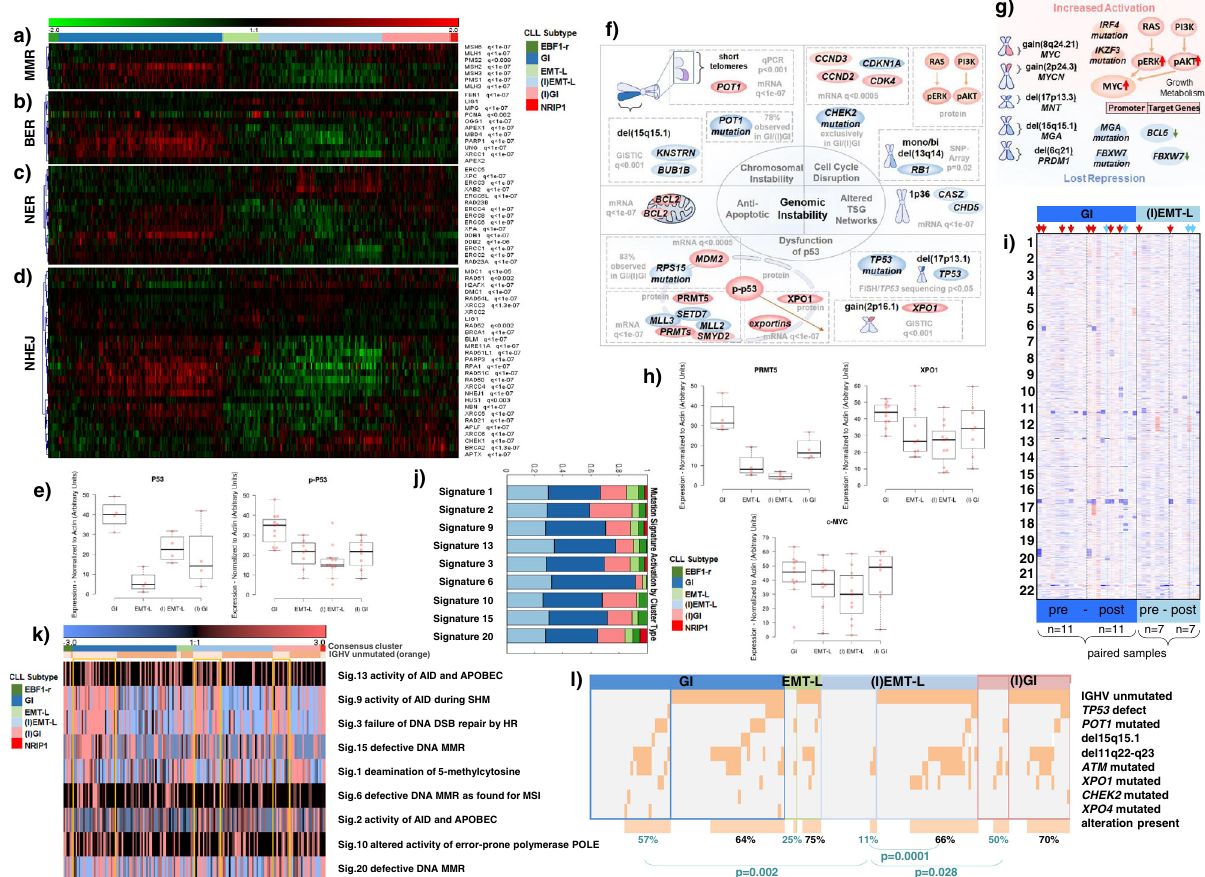
Fig. 3 Biological processes operative in genomically instable CLL. a – d Heatmap showing expression pro fi les ( n = 337) for genes involved in a mismatch repair (MMR), b base excision repair (BER), c nucleotide excision repair (NER), d non-homologous end joining (NHEJ). FDRs of DEGs (GI vs. (I)EMT-L) are indicated (q). Single genes may be involved in multiple processes. e Protein expression in CLL subtypes; p53 ( n = 4 each), phospho-p53 (GI/(I)EMT-L: n = 11 each, (I)GI/EMT-L: n = 8 each) (normalized to actin). f , g Models summarizing alterations which contribute to f genomic instability, g activation of MYC family members in GI/(I)GI. Source/method (e.g., mRNA/GISTIC) and signi fi cance/frequencies are shown in gray, along with estimated mode of regulation/biological effect (red: increase/activation; blue: decrease/inactivation). h Protein expression in CLL subtypes; PRMT5 ( n = 4 each), XPO1/ cMYC (GI/(I)EMT-L: n = 11 each, (I)GI/EMT-L: n = 8 each) (normalized to actin). i Heatmap showing CNAs (paired CLL8 cases; before treatment (pre), at relapse (post)). CNAs are frequent at relapse ( TP53 wild-type: GI/(I)EMT-L; p < 0.05, Wilcoxon signed-rank test (two-sided)). GI cases show